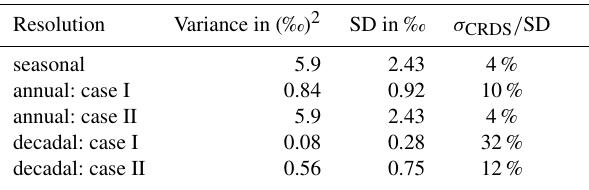
Table 2. Noise variance and standard deviation (SD) of the trench data together with the ratio of measurement uncertainty ( σ CRDS = 0 . 09‰) and respective noise SD, given for different resolutions and for the two limiting cases of the annual noise variance. The decadal noise level estimates are calculated from the annual noise variances accounting for full forward